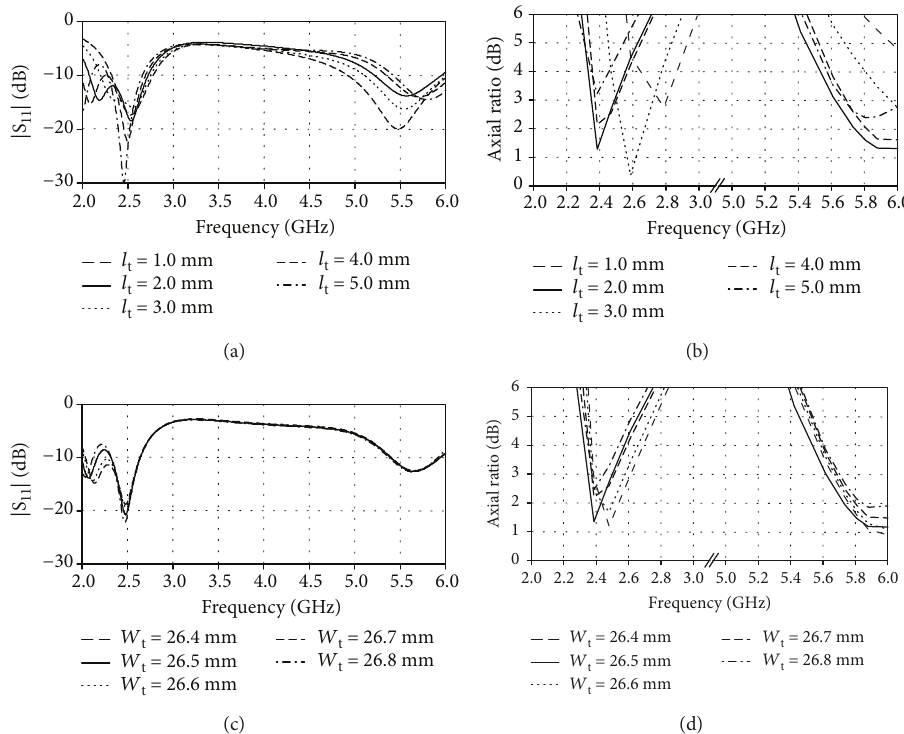
w 11 when t is varied, (b) axial ratio when